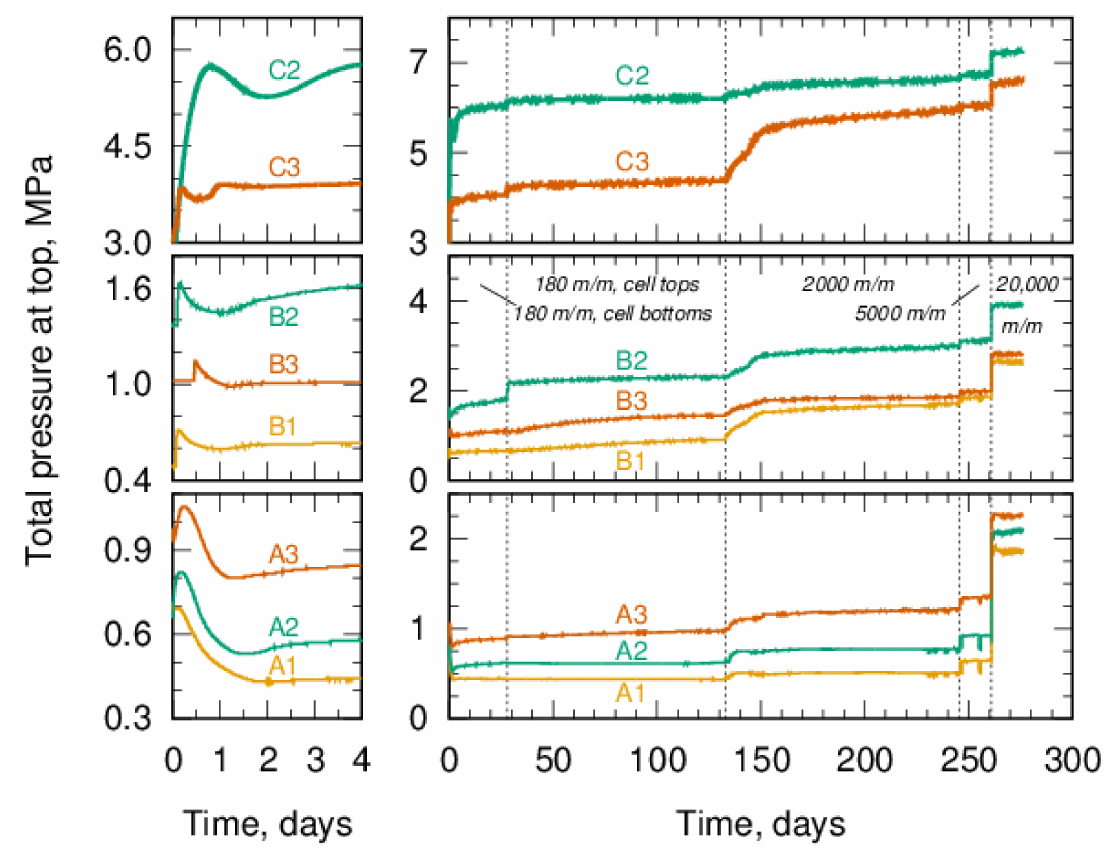
Figure 3. Total pressure at tops of permeameter cells for 10X specimens compacted to dry densities of 1.4 g/cm 3 (cells A1–A3); 1.6 g/cm 3 (cells B1–B3); and 1.8 g/cm 3 (cells C2, C3), saturated and permeated by SGW. Graphs on left-side represent x- and y -axis close-ups of the data measured within the first four days of saturation. Vertical dotted lines mark onsets of solution supply by burettes through cell tops (28th day) and by the pump at hydraulic gradients of 2000 m/m (133rd day), 5000 m/m (246th day), and 20,000 m/m (261st day) (note that corresponding labels in the 2nd graph on